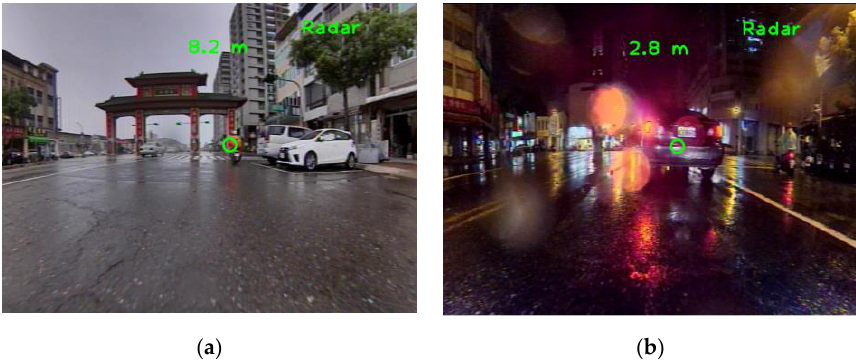
Figure 16. Detection results of radar subsystem for a rainy day, ( a ) motorcycle and ( b ) car.